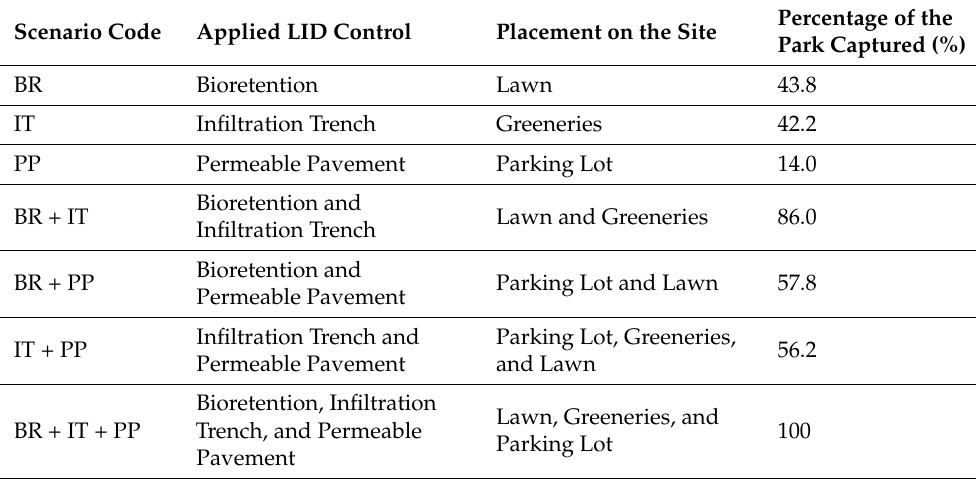
Table 2. LID scenarios used in the